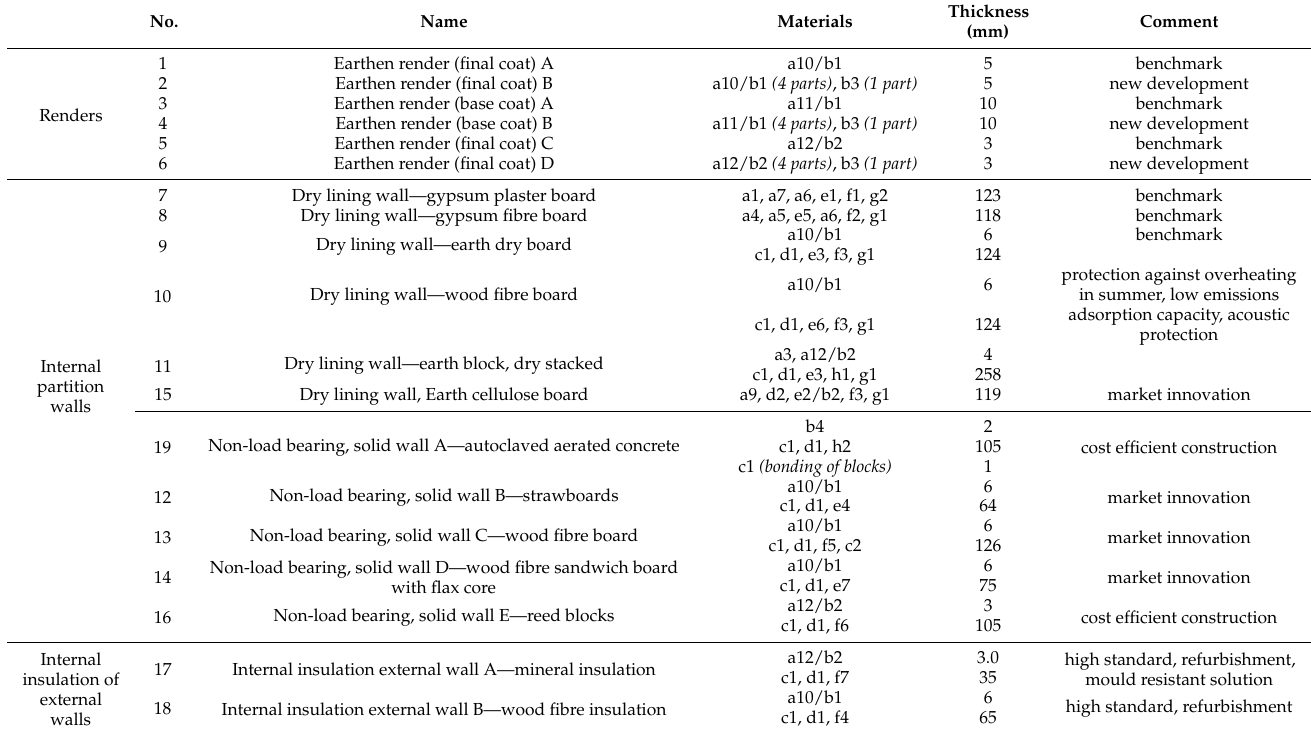
Table 2. Matrix of sample build-ups. Material identifiers (Reference to Table 1) are listed in the order of their installation in the sample, starting with the side facing the